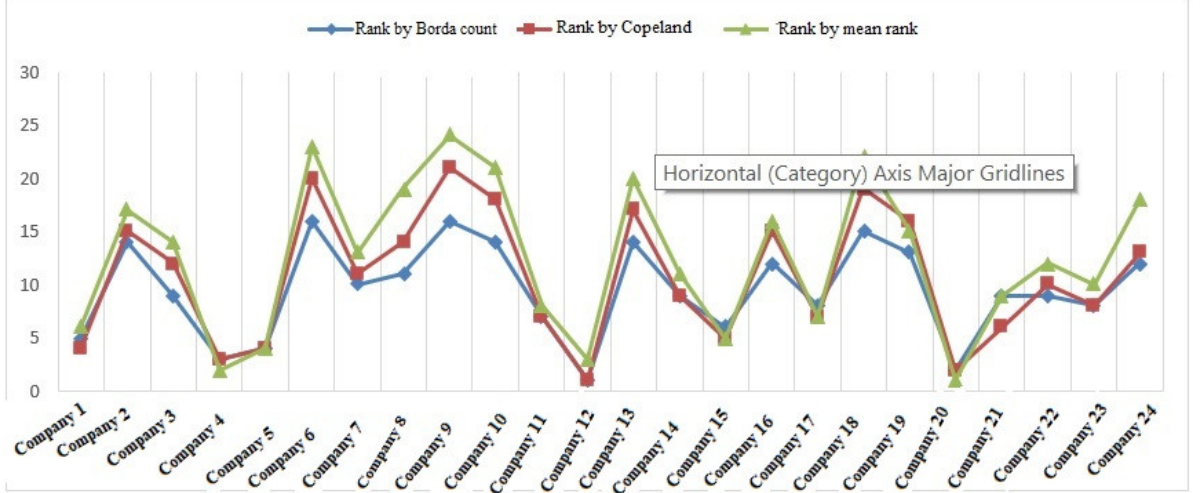
Figure 2. Comparison of three mean ranks, Borda count, and Copeland methods for 24 companies. According to Table 5 and experts’ opinion, five companies that ranked first or had a better rank were selected (for example, Company 12 ranked first Borda count and Copeland method and third in the mean ranks, and Compant 20 ranked second in the Borda count and Copeland method and first in the mean ranks). Then, 10 criteria were analyzed for data homogeneity to confirm the results shown in Table 6 and Figure